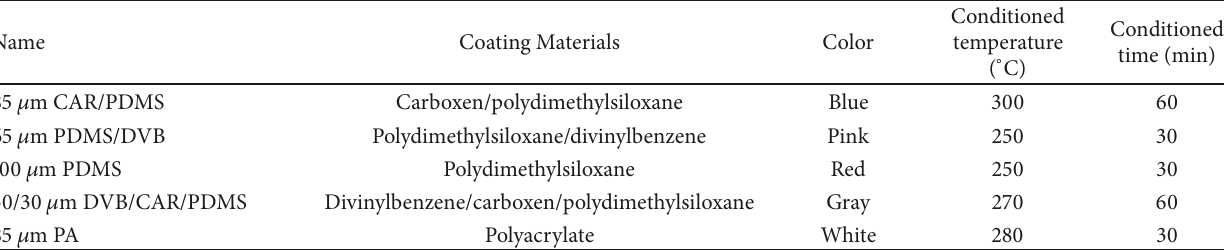
Table 1: The five types of